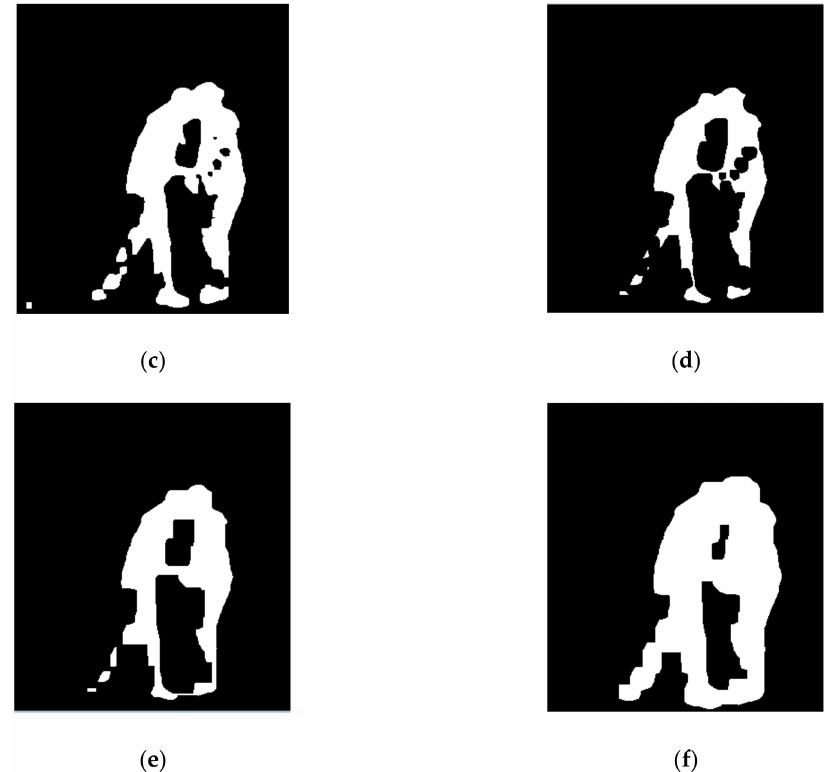
Figure 5. Morphological processing: ( a ) original image; ( b ) target extraction and binarization; ( c ) opening operation; ( d ) erosion; ( e ) closing operation; and ( f ) dilation.